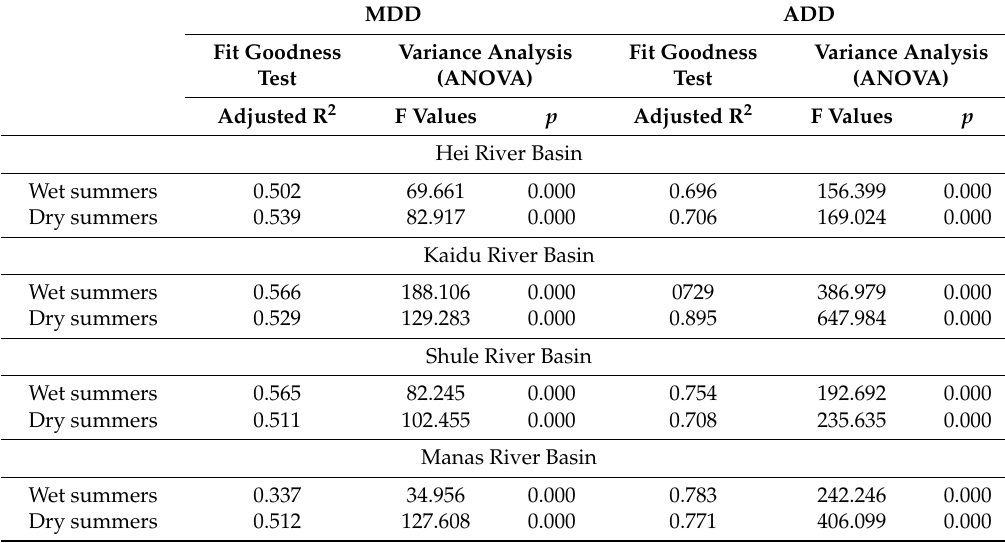
Table 5. The significances of linear regression equations where dependent variables are runoff indices (MDD and ADD), and the independent variables are precipitation and temperature indices (MDP, DPP, APA, DP, IP, AT, MnT, and MT) for each selected basin during wet and dry summers.